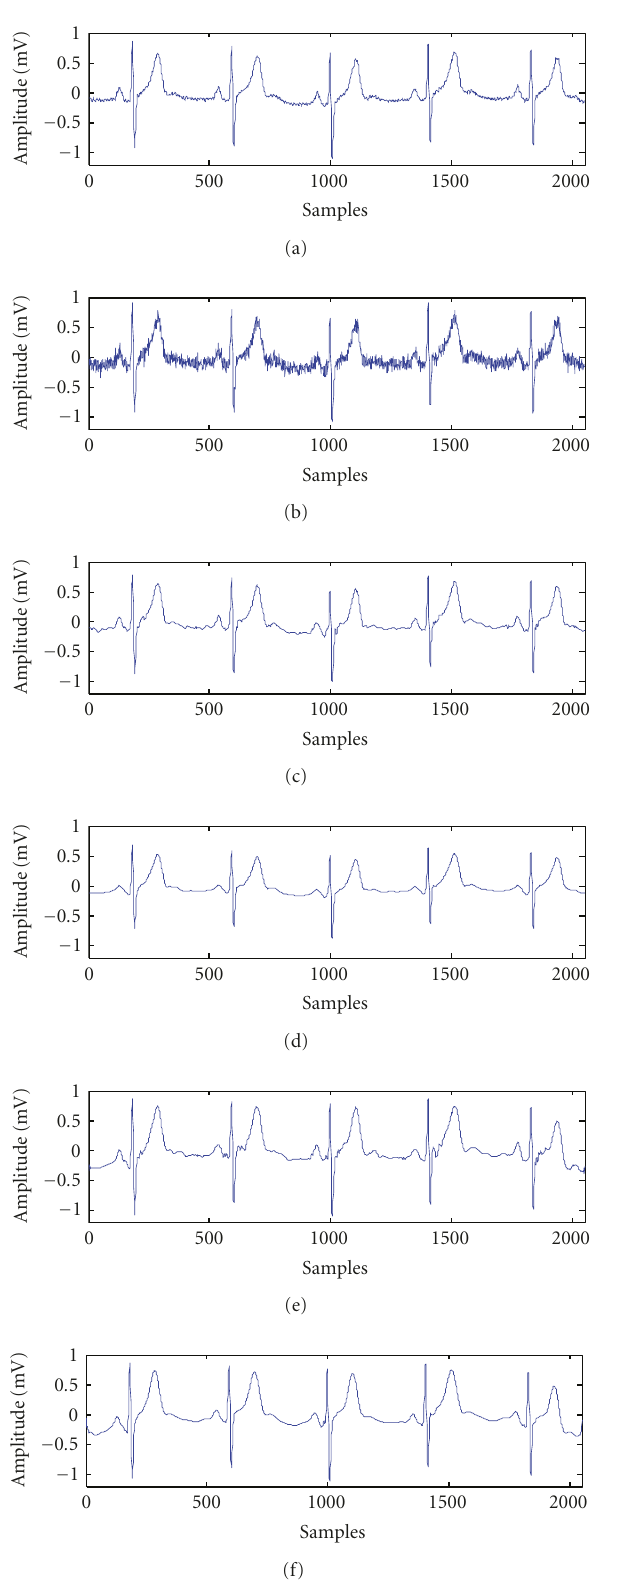
Figure 6: Typical results of di ff erent methods for the MIT-BIH record 117 with an input SNR of 4 dB. (a) Clean ECG, (b) noisy in- put signal, (c) WT (hard), (d) WT (soft), (e) MABWT (hard), and (f) MABWT (soft).